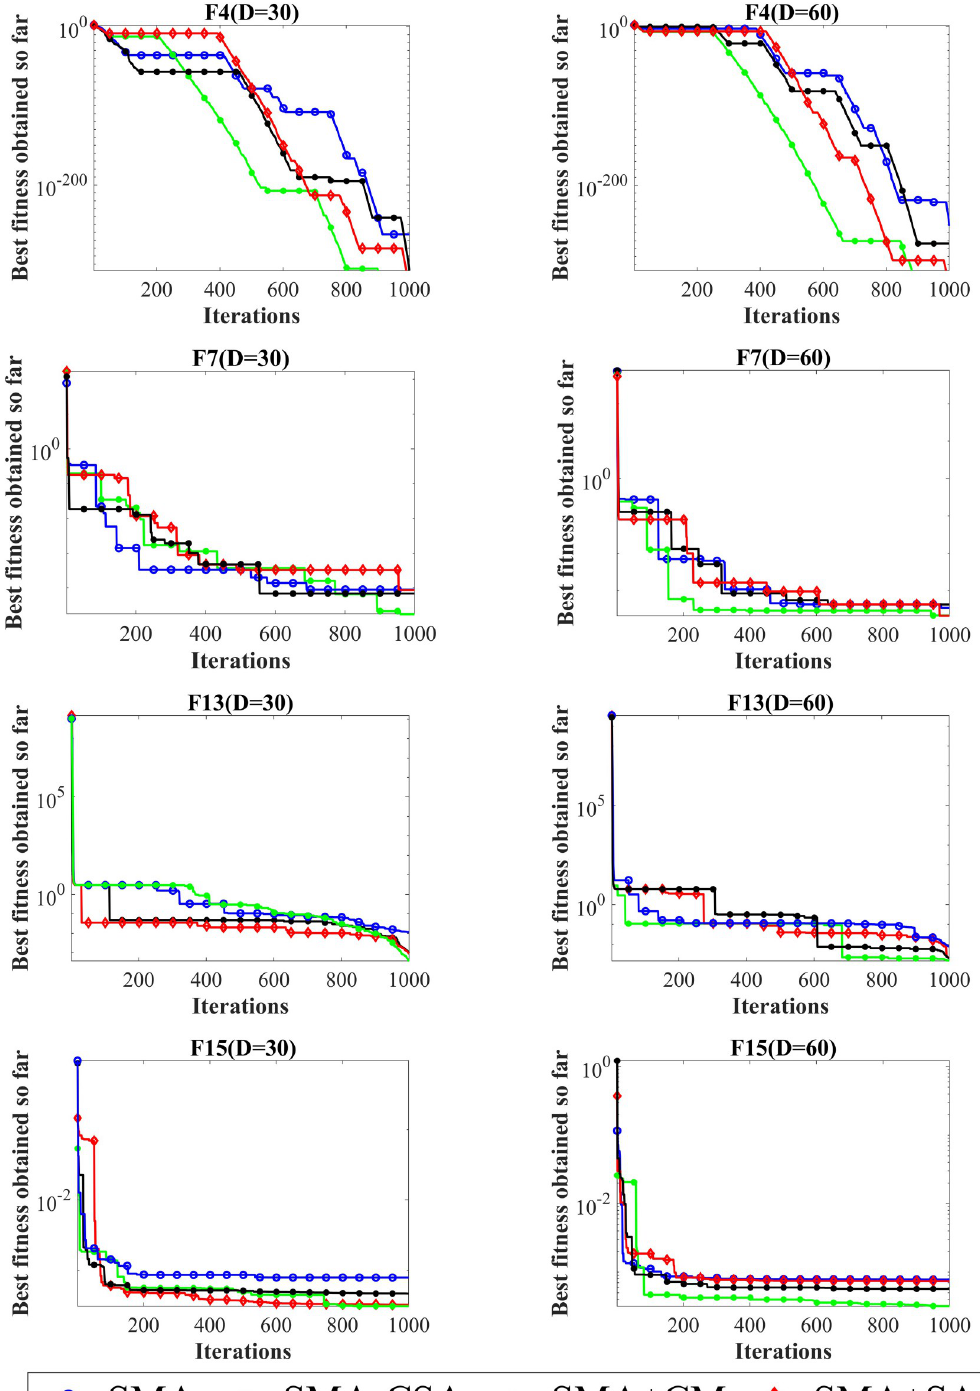
Fig 4. Fitness values obtained by SMA, SMA+SA, SMA+CM and SMA-CSA.